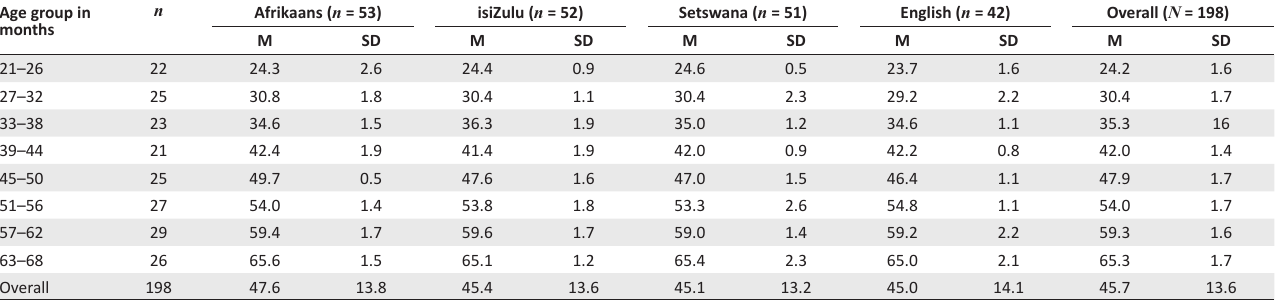
TABLE 1: Participant age groups across languages. Age group in months